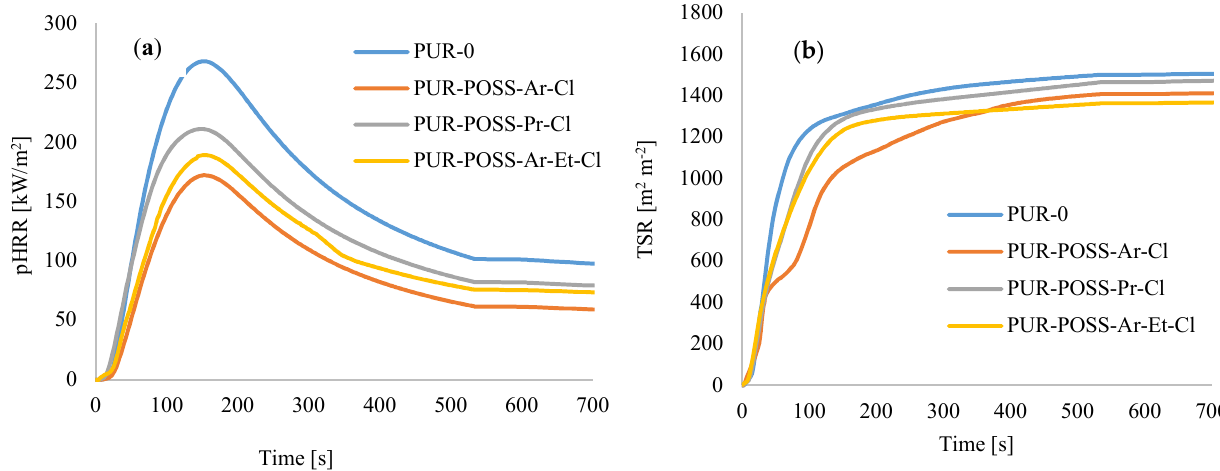
Figure 7. The results of the cone calorimeter test—( a ) the peak rate of heat release (pHRR), ( b ) the total smoke release (TSR).